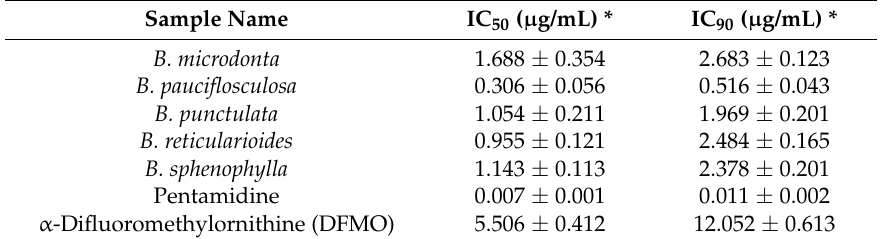
Table 3. In vitro antitrypanosomal activity of essential oils of Baccharis species against T.